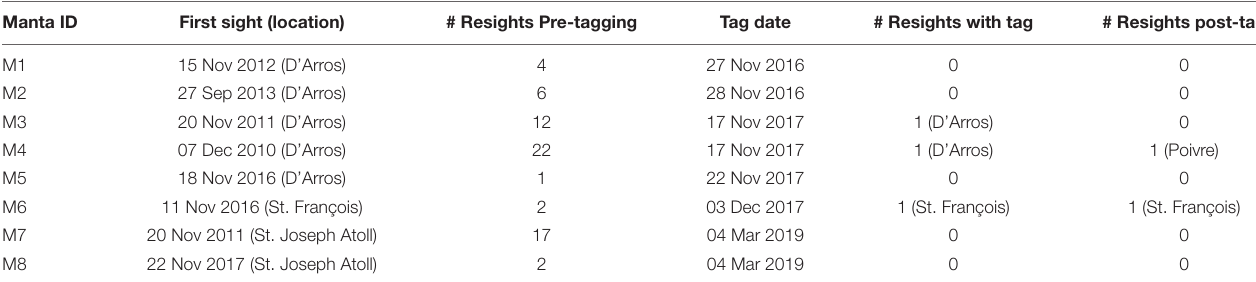
FIGURE 2 | Re-sighting frequency of individual reef manta rays ( Mobula alfredi ) identified using photo-identification techniques in Seychelles (July 2006 to December 2019). Individuals ranked from most to least re-sightings. Time between first sighting and most recent sighting described in the legend. Arrows highlight individuals that were sighted in two of the seven Island Groups of Seychelles. The remaining individuals were always re-sighted at islands and/or atolls within the same Island Group. TABLE 2 | Sighting histories and locations of eight individual reef manta rays ( Mobula alfredi ) that were tracked in the waters of Seychelles using archival pop-up satellite